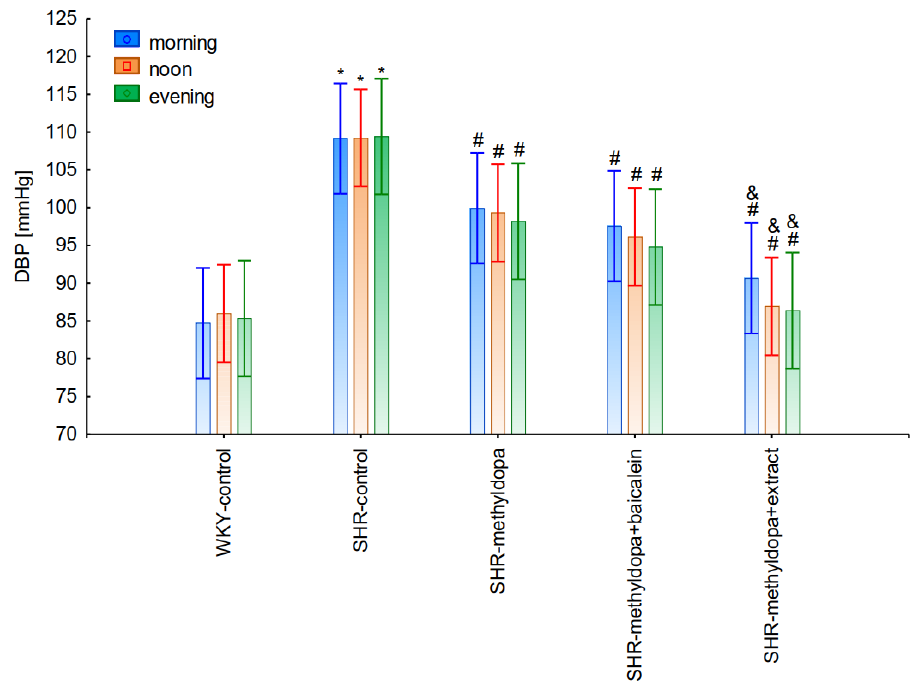
Figure 11. Changes in diastolic blood pressure (DBP) after administration of methyldopa and its combination with baicalein and Scutellaria baicalensis root extract with regard to the time of day of administration in SHR pregnant rats. Legend: n = 10, mean ± SEM; *—vs. proper WKY control, p < 0.05; #—vs. proper SHR control, p < 0.05; &—vs. proper SHR-methyldopa, p < 0.05.